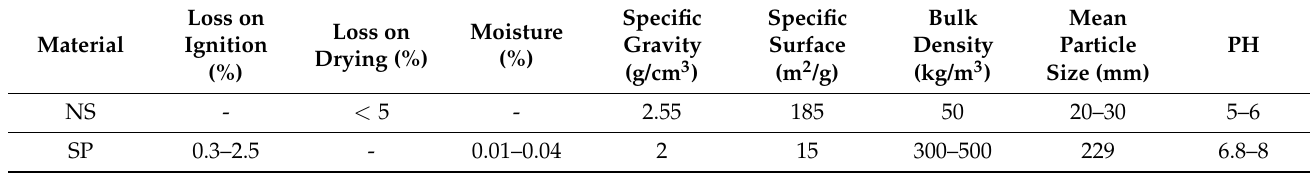
Table 7. Physical properties of SP and